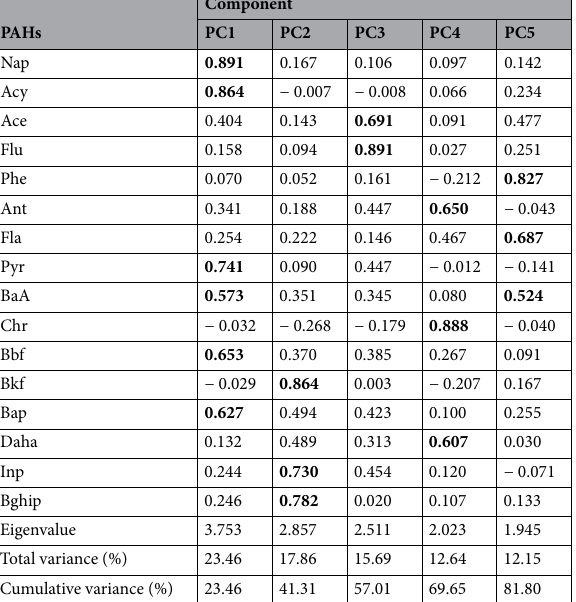
Table 2. Factor analysis scores following Varimax rotation for all PAHs (factor loadings > 0.5 are shown in